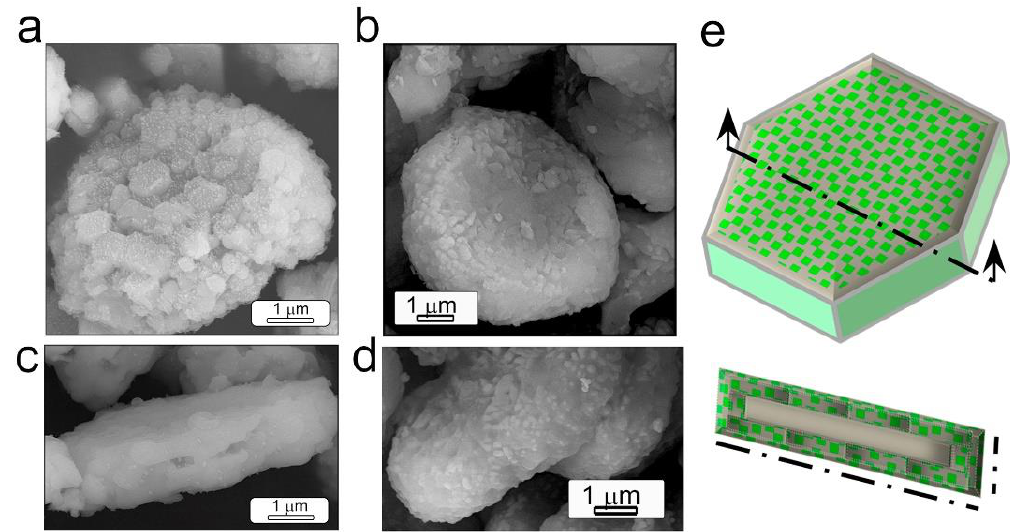
Figure 6. ( a – d ) Field-emission scanning electron microscopy (FE-SEM) micrographs of the synthesized particles based on SrAl 2 O 4 :Eu, Dy and CaAl 2 O 4 :Eu, Nd. ( e ) Scheme of the surface and cross-section of the nanostructures obtained with a platelet-like morphology.